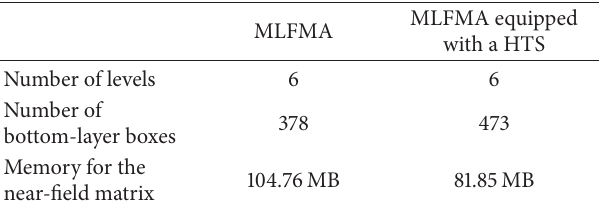
Table 2: Comparison between the two MLFMAs in Section